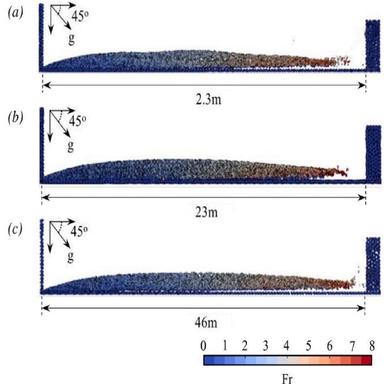
Froude number distribution from geometrically scaled models by (a)